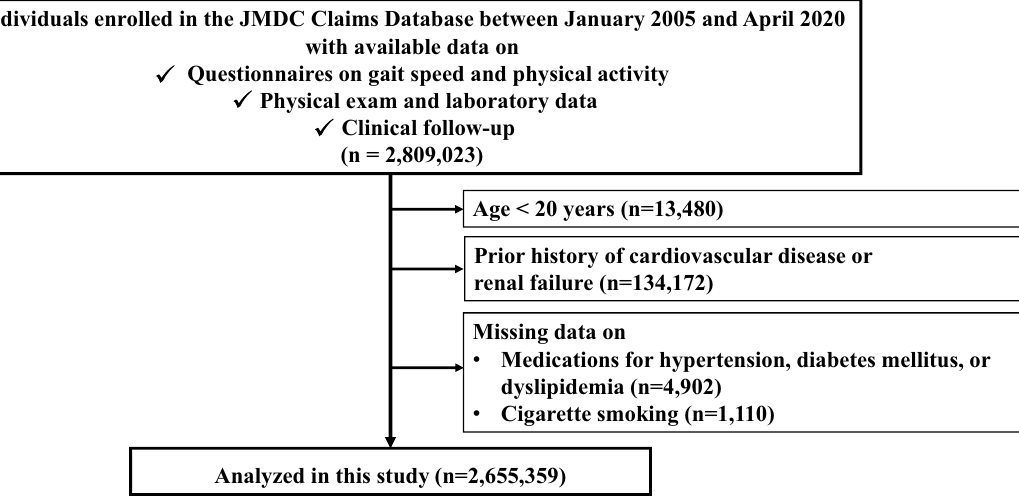
Figure 1. We extracted the data of 2,809,023 individuals who were enrolled in the JMDC Claims Database between January 2005 and April 2020 and whose baseline health check-up data (including data on gait speed) were available. Exclusion criteria were as follows: (1) age < 20 years (n = 13,480); (2) prior history of heart failure, myocardial infarction, angina pectoris, stroke, or renal failure (n = 134,172); and (3) missing data on medications for hypertension, diabetes mellitus, or dyslipidemia (n = 4902) and cigarette smoking (n = 1110). Finally, we analyzed 2,655,359 participants in this